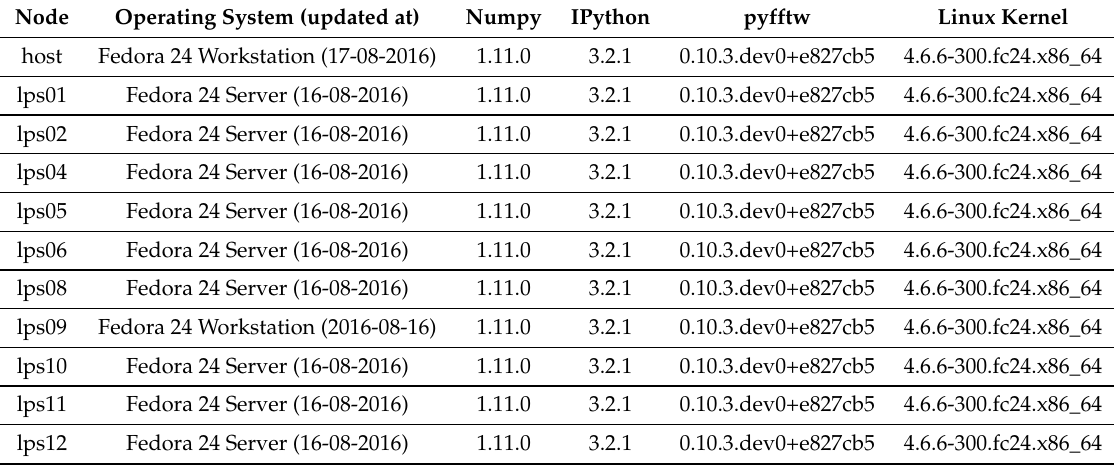
Table A3. Cluster software configuration. Updated at shows when each cluster node was last fully